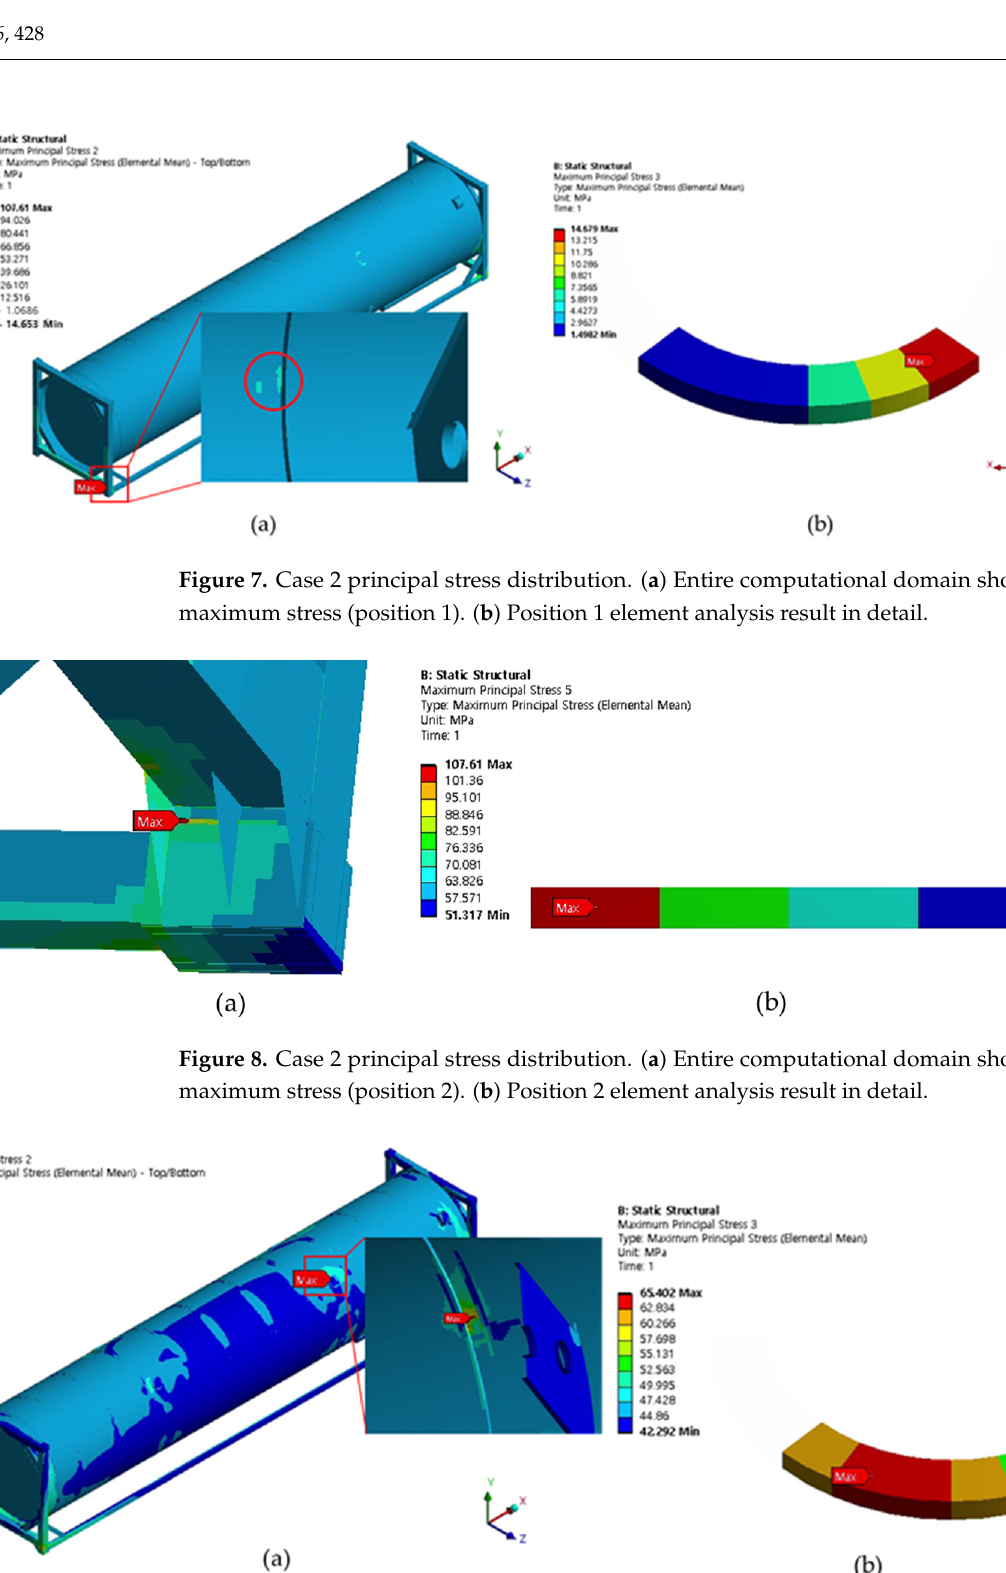
Figure 10. Case 3 principal stress distribution. ( a ) Entire computational domain showing region of maximum stress (position 2). ( b ) Position 2 element analysis result in detail.